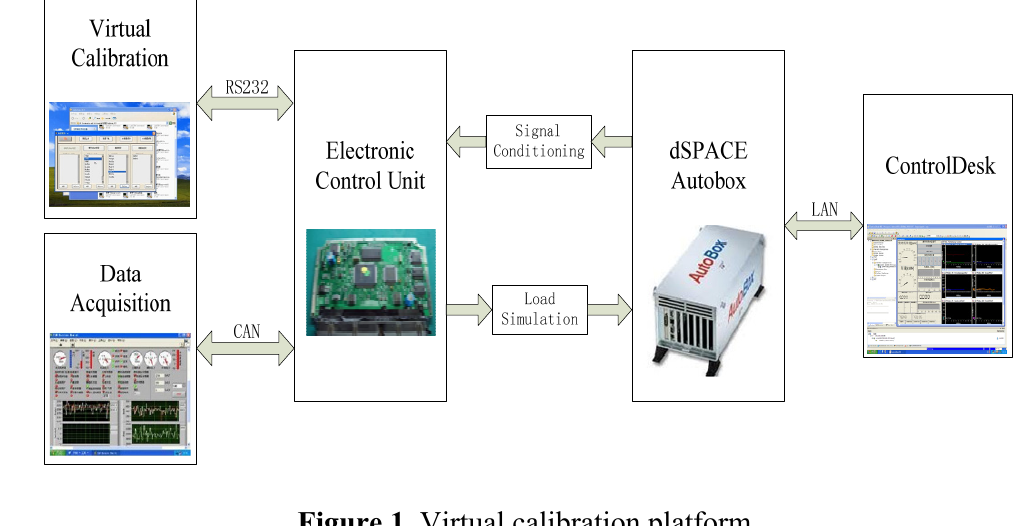
Figure 1. Virtual calibration platform.